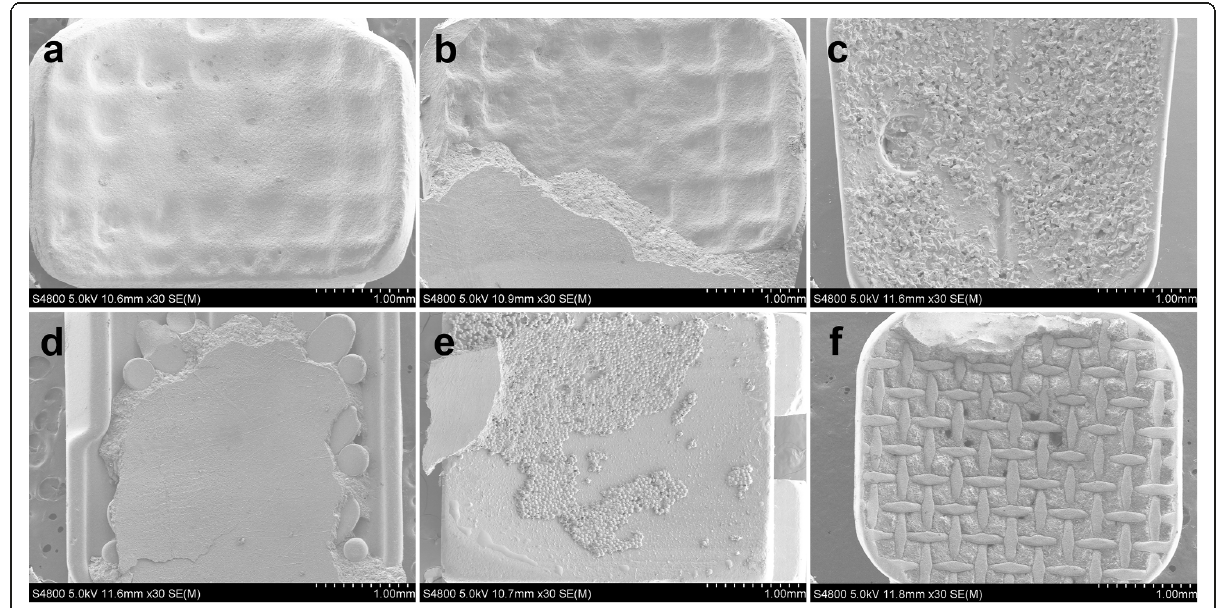
Fig. 6 SEM images of debonding bases at 30×: a CCB-E; b CCB-ES; c CA; d C7; e IC; f